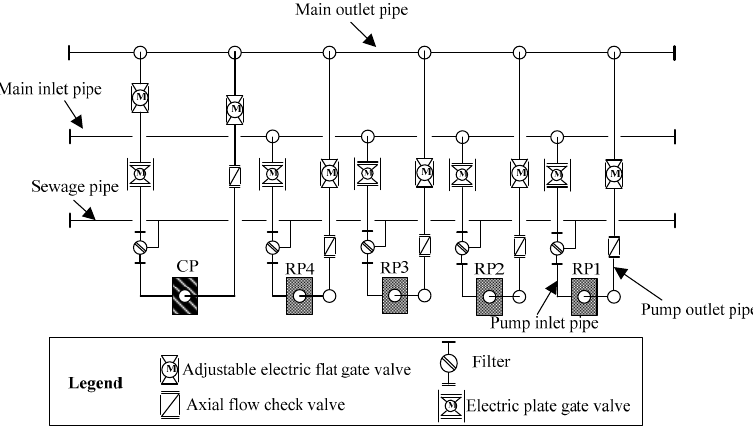
Figure 13. Sketch map of pipeline distribution in the transmission area (Note: RP represents the reciprocating pump, CP represents centrifugal pump). Table 4. Parameters of the pipelines in the transmission area.